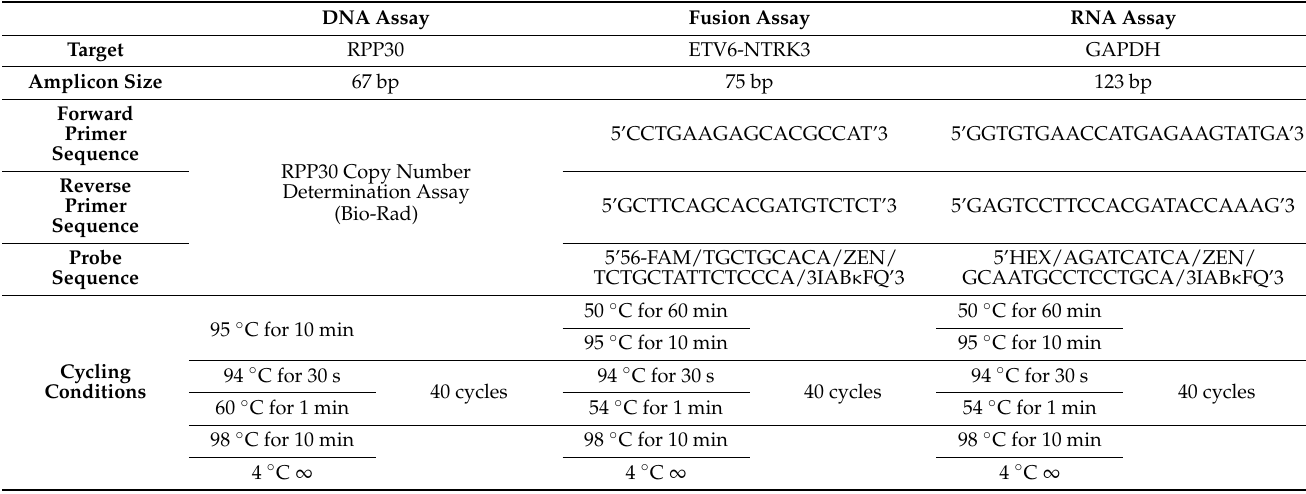
Table 2. ddPCR conditions. Assay specifics for detection of RPP30 (Ribonuclease P/MRP Subunit P30), ETV6-NTRK3 (fusion of ETS Variant Transcription Factor 6 and Neurotrophic Receptor Tyrosine Kinase 3), and GAPDH (glyceraldehyde- 3-phosphate dehydrogenase). Probes were labeled with FAM (5(6)-Carboxyfluorescein) or HEX (Hexachloro-fluorescein). For improved self-quenching, we used double probes for RNA detection. In addition to Iowa Black ® FQ (3IABkFQ/), an internal ZEN™ quencher, was